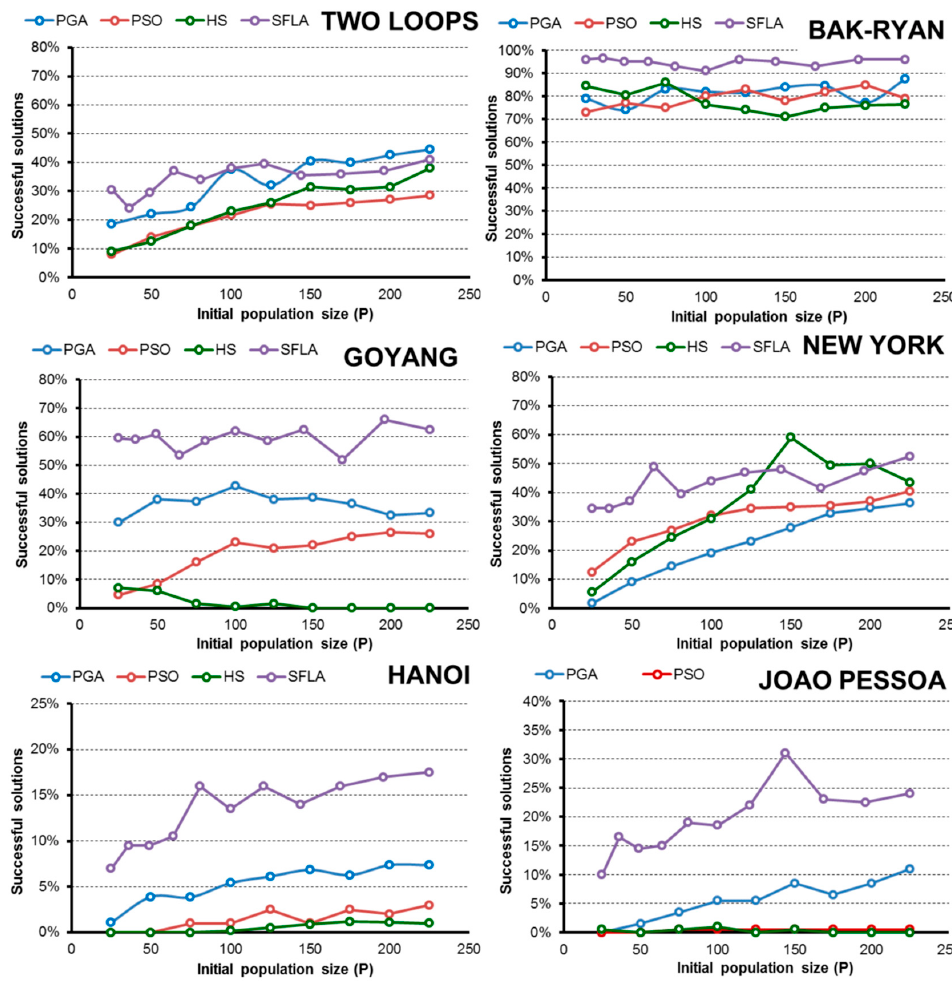
Figure 1. Low ‐ cost solution rate of each network and algorithm based on initial population size P .